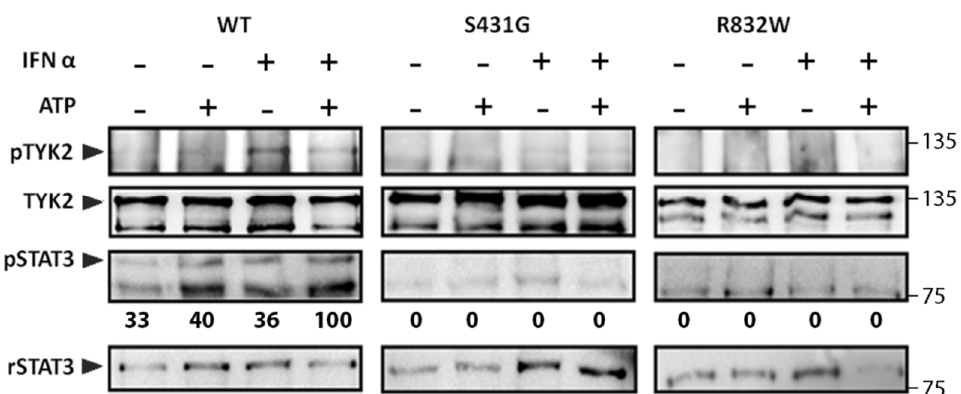
Figure 4. In vitro kinase activity of TYK2 WT, TYK2 S431G, and TYK2 R832W proteins. TYK2 was immunoprecipitated with anti-TYK2 Ab from non-stimulated cells or cells stimulated with IFN α (500 pM) for 15 min and subjected to in vitro kinase reaction in the presence or absence of 30 μ M ATP for 5 min at 30 °C. Recombinant STAT3 (rSTAT3) was added to the reaction as exogenous substrate. The phosphorylation level of the indicated proteins was analysed by immunoblotting. STAT3 phosphorylation was represented relative to rSTAT3 and then to TYK2, to account for differences in the amount of immunoprecipitated TYK2 in each sample. Values are expressed as percentage of the highest value of each membrane. A representative result of three independent experiments is shown.